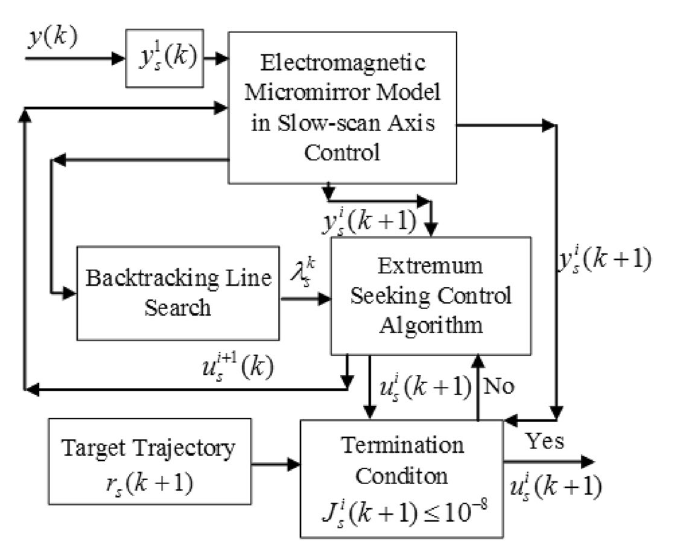
Figure 5. Flowchart of MGESC with BTLS